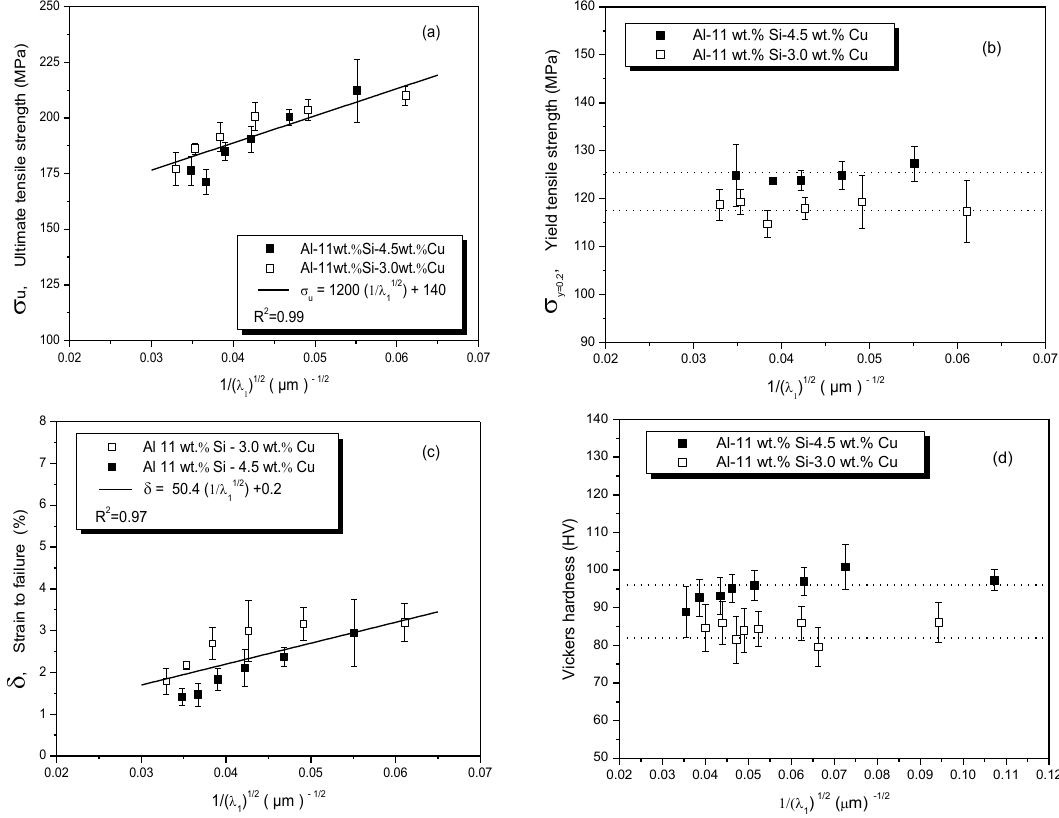
Figure 17. ( a ) Ultimate, ( b ) yield tensile strength, ( c ) elongation, and ( d ) Vickers hardness as a function function of the primary dendritic spacing for the Al-11wt %Si- x wt %Cu alloys. R 2 is the coefficient of the primary dendritic spacing for the Al-11wt. %Si- x wt. %Cu alloys. R 2 is the coefficient of of determination.